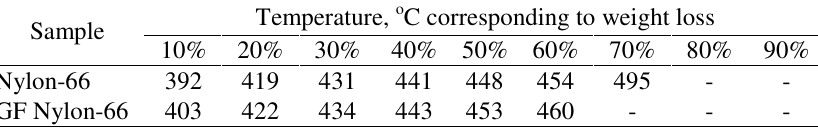
Table 3. Thermal stability of polymeric